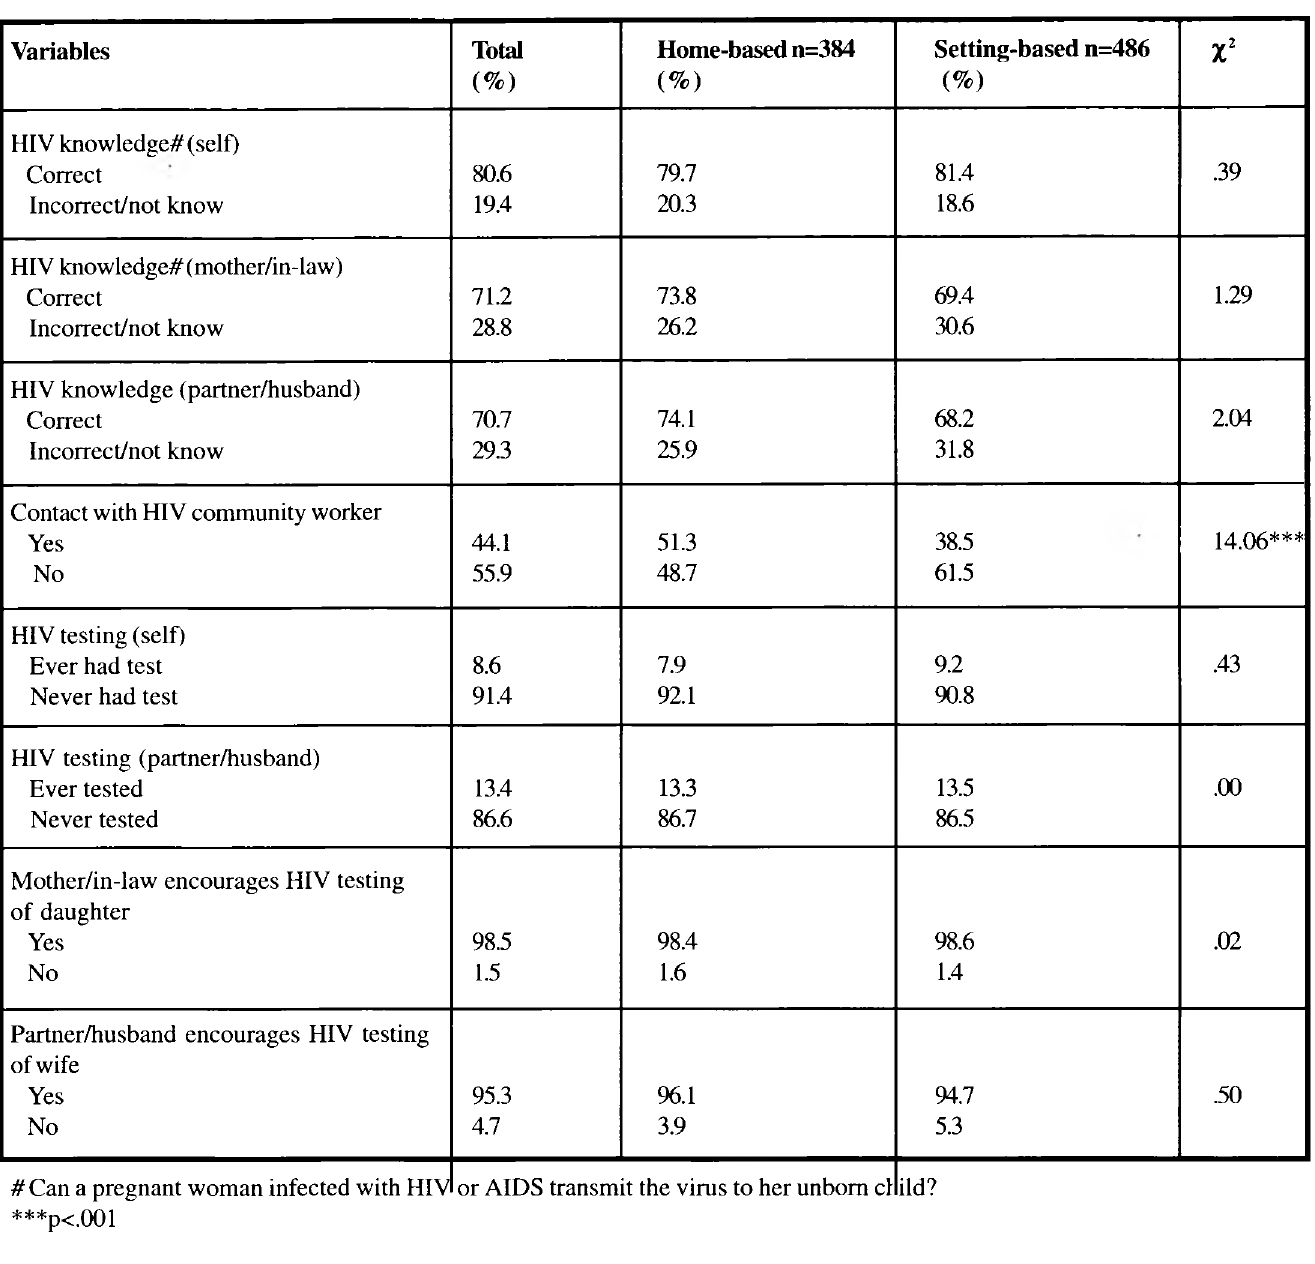
Table 5: HIV/AIDS knowledge and HIV testing by delivery option